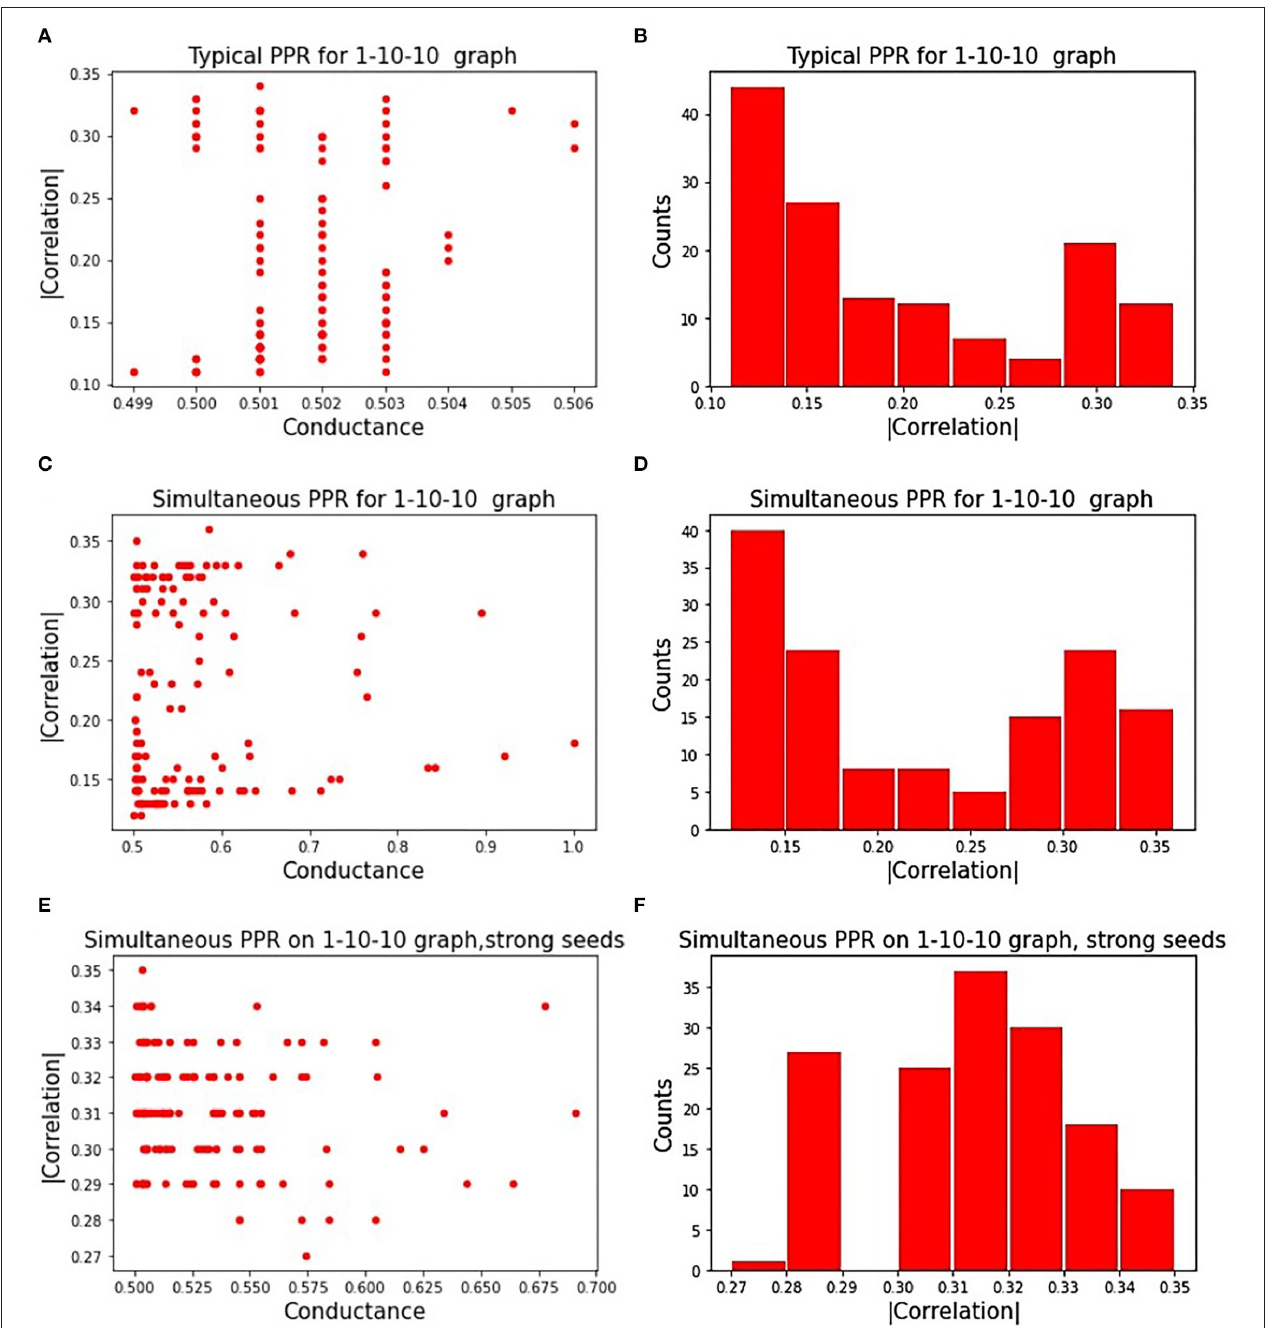
FIGURE 3 | Correlated PageRank results: (A) shows the randomized search results for the sequential approach to Correlated PageRank; (B) shows a distribution of | ρ | for subgraphs identified by sequential Correlated PageRank with randomized seed selection; (C) shows randomized search results for the simultaneous approach to Correlated PageRank; (D) shows a distribution of | ρ | for subgraphs identified by simultaneous Correlated PageRank with randomized seed selection; (E) shows randomized search results for simultaneous Correlated PageRank with selected strong seeds only; (F) shows a distribution of | ρ | for simultaneous Correlated PageRank with strong